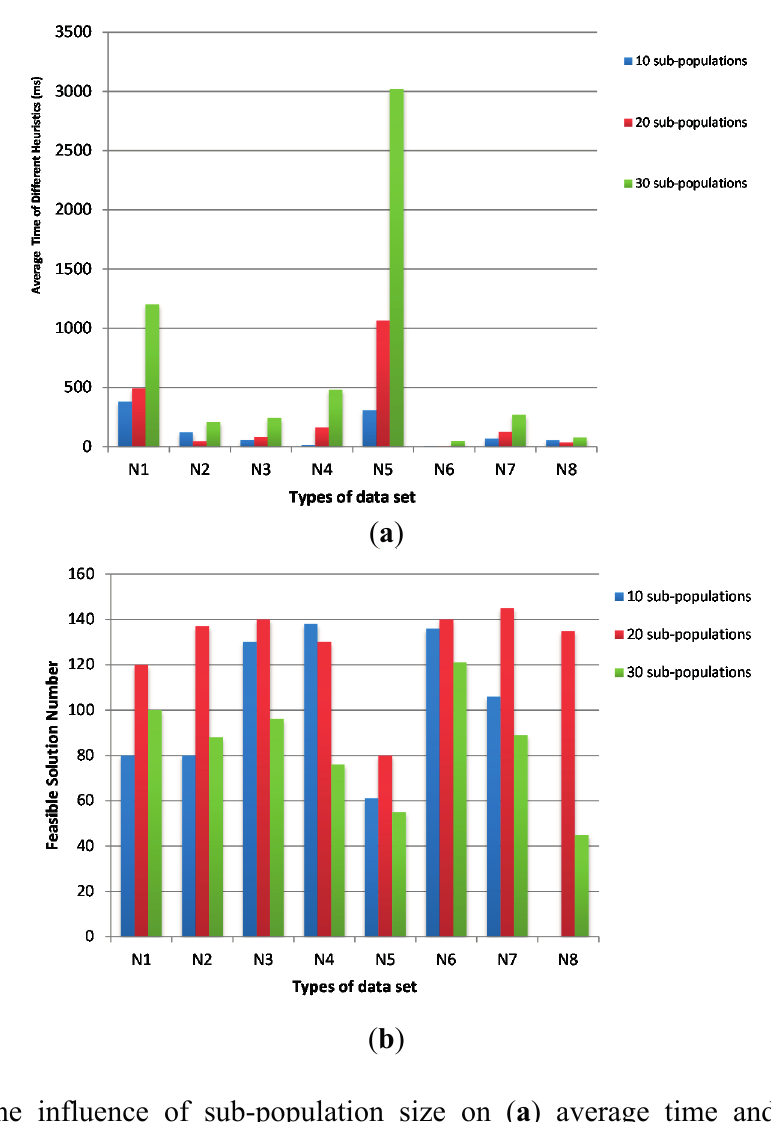
Figure 5. The influence of sub-population size on ( a ) average time and ( b ) feasible solution number.